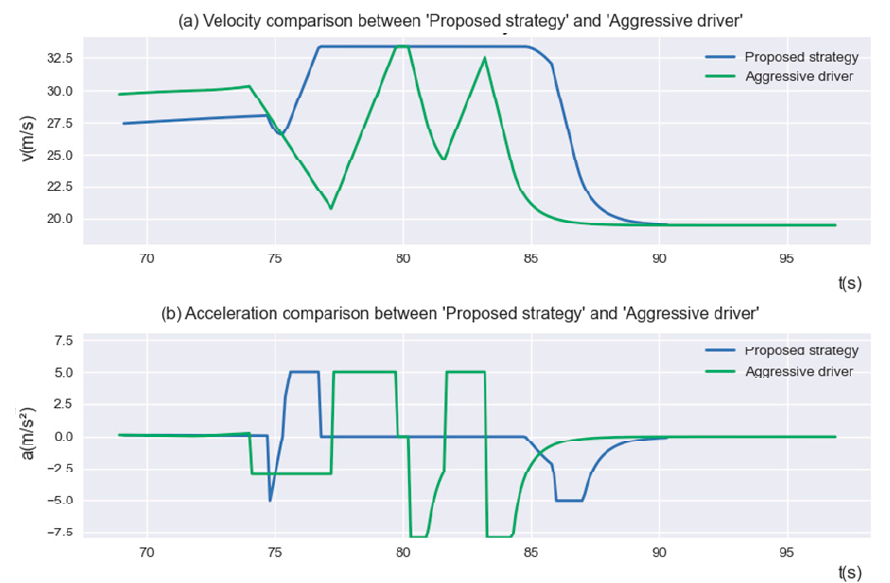
Figure 10. The velocity and acceleration of “Proposed strategy” and “Aggressive driver”.